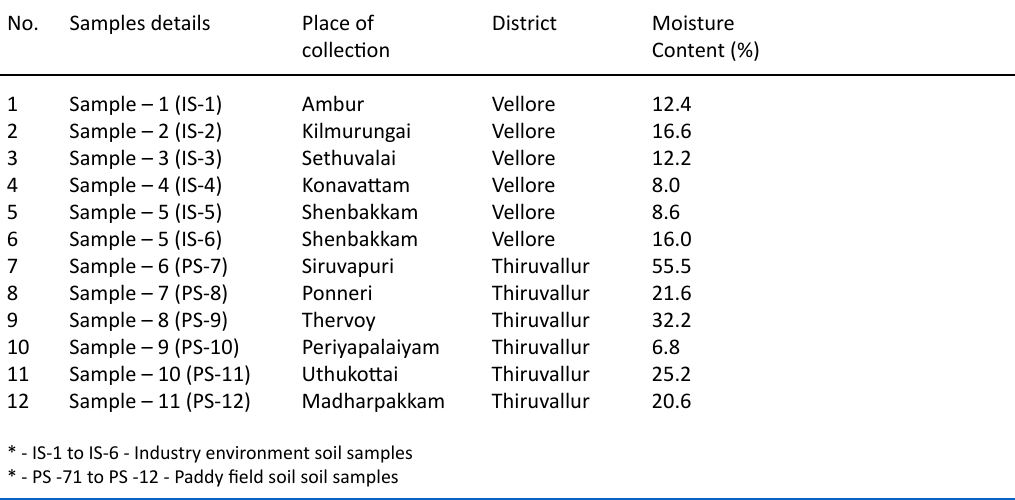
Table 1. Details of soil samples collection and it moisture content